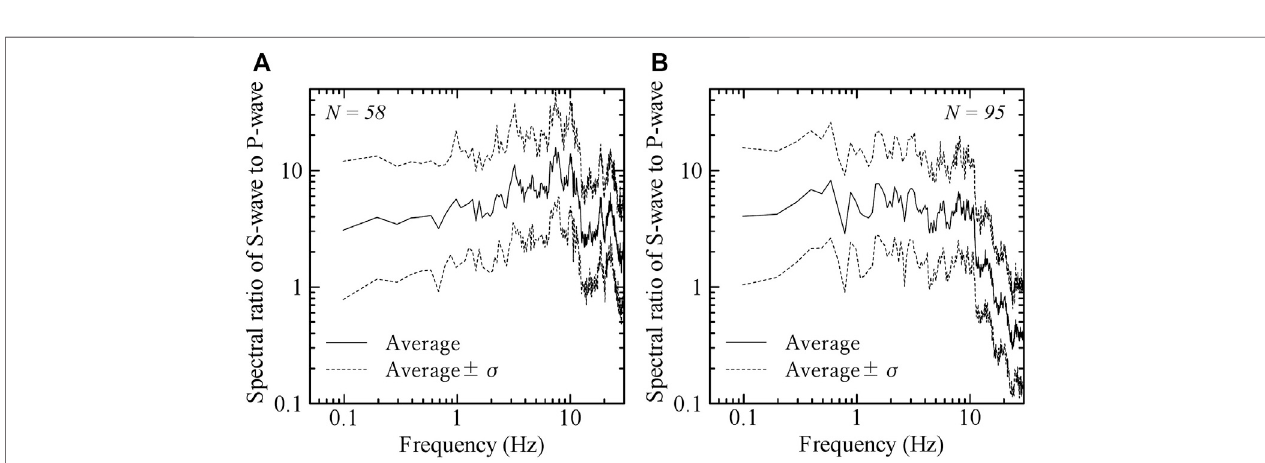
FIGURE4| Estimatedsite-speci fi cspectralratiosofS-wavetoP-waveforatime-windowof10.24 satKSandSSstations. N inthe fi guresindicatesthenumberof earthquakes used. (A) KS station (B) SS station.